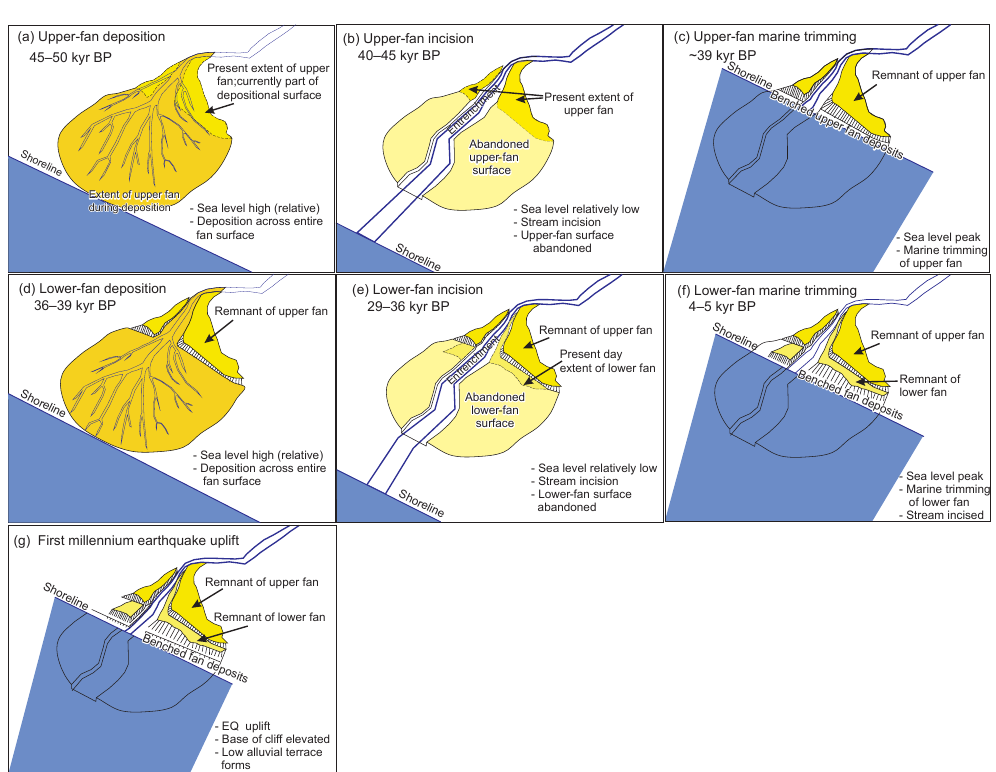
Figure 10. The sequence of events that contributed to the development of the landscape at Domata is schematically illustrated: (a) upper- fan deposition due to sea-level high stand (base level); (b) abandonment of the upper-fan surface due to falling sea level; (c) sea-level rise resulting in the trimming of the upper-fan deposits and cutting of a marine bench; (d) lower-fan deposition starts during relatively high sea level and laps against both the river incision cliff and the coastal cliff in the upper fan; (e) as sea level falls, the lower-fan surface is abandoned through entrenchment; (f) a return to high sea level results in coastal trimming of the lower-fan deposits; (g) one or more earthquakes in the first millennium AD resulted in 6m of uplift at Domata and corresponding adjustments to the lower Klados River geomorphology. The approximate chronology of each stage is